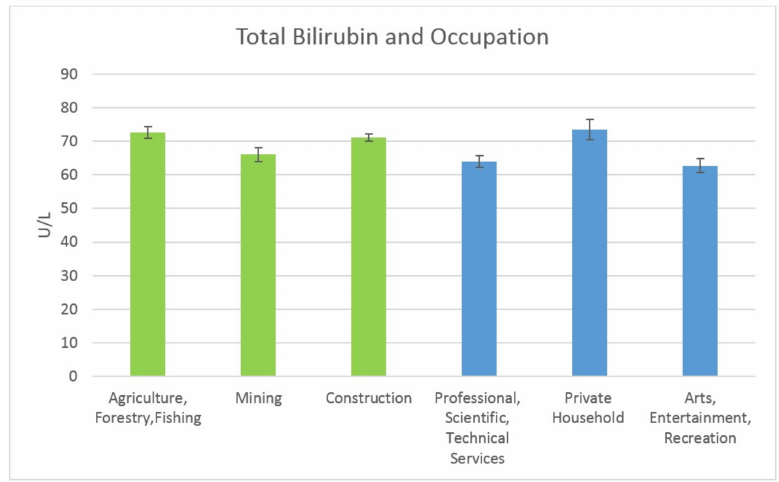
Figure 5. Occupation and Total Bilirubin Levels.